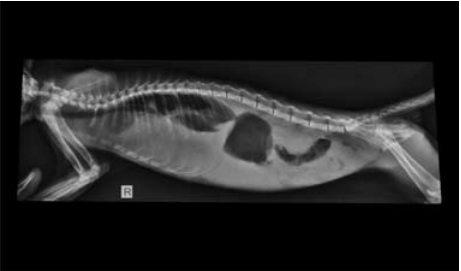
Fig. 1: Right lateral thoracic radiography on day 1